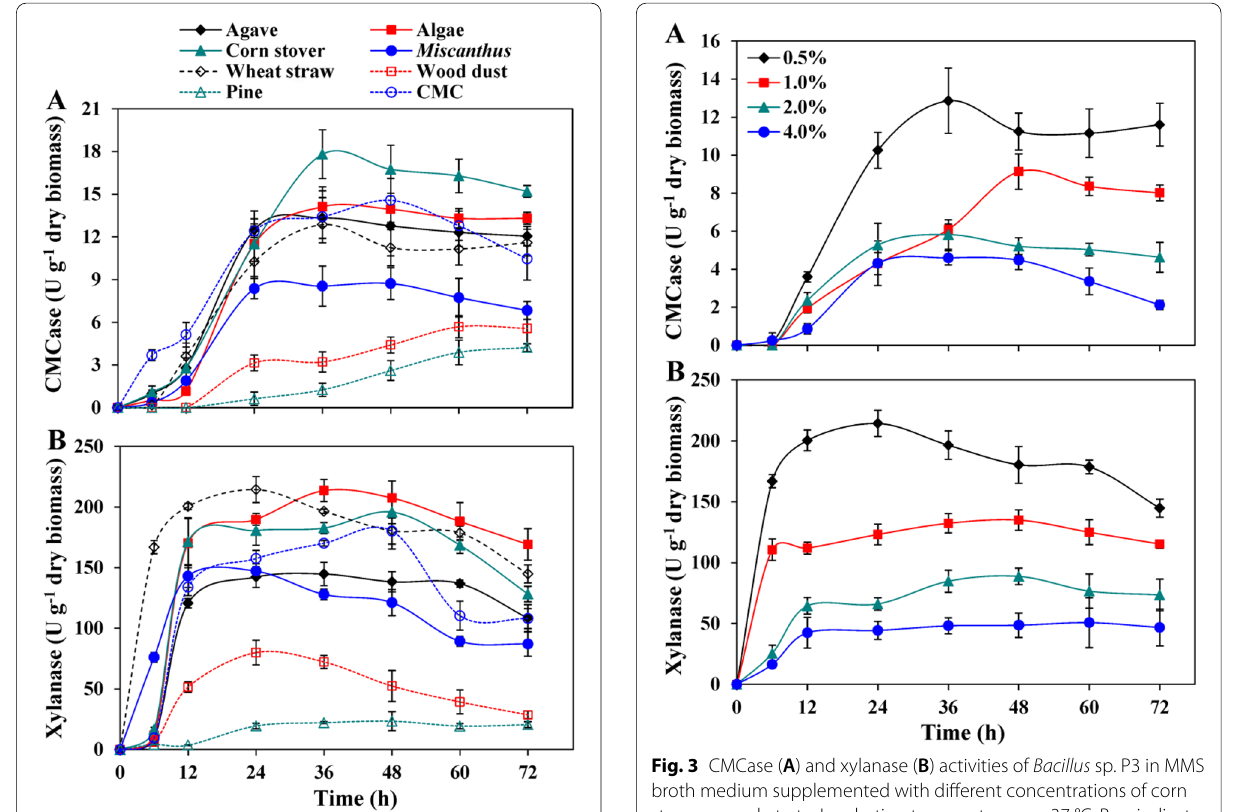
Fig. 2 CMCase ( A ) and xylanase ( B ) activities of the Bacillus sp. P3 strain cultivated in MMS broth medium at 0.5% (w/v) of different biomasses and CMC. Incubation temperature was 37 °C. Bars indicate the standard deviation ( n 3) =